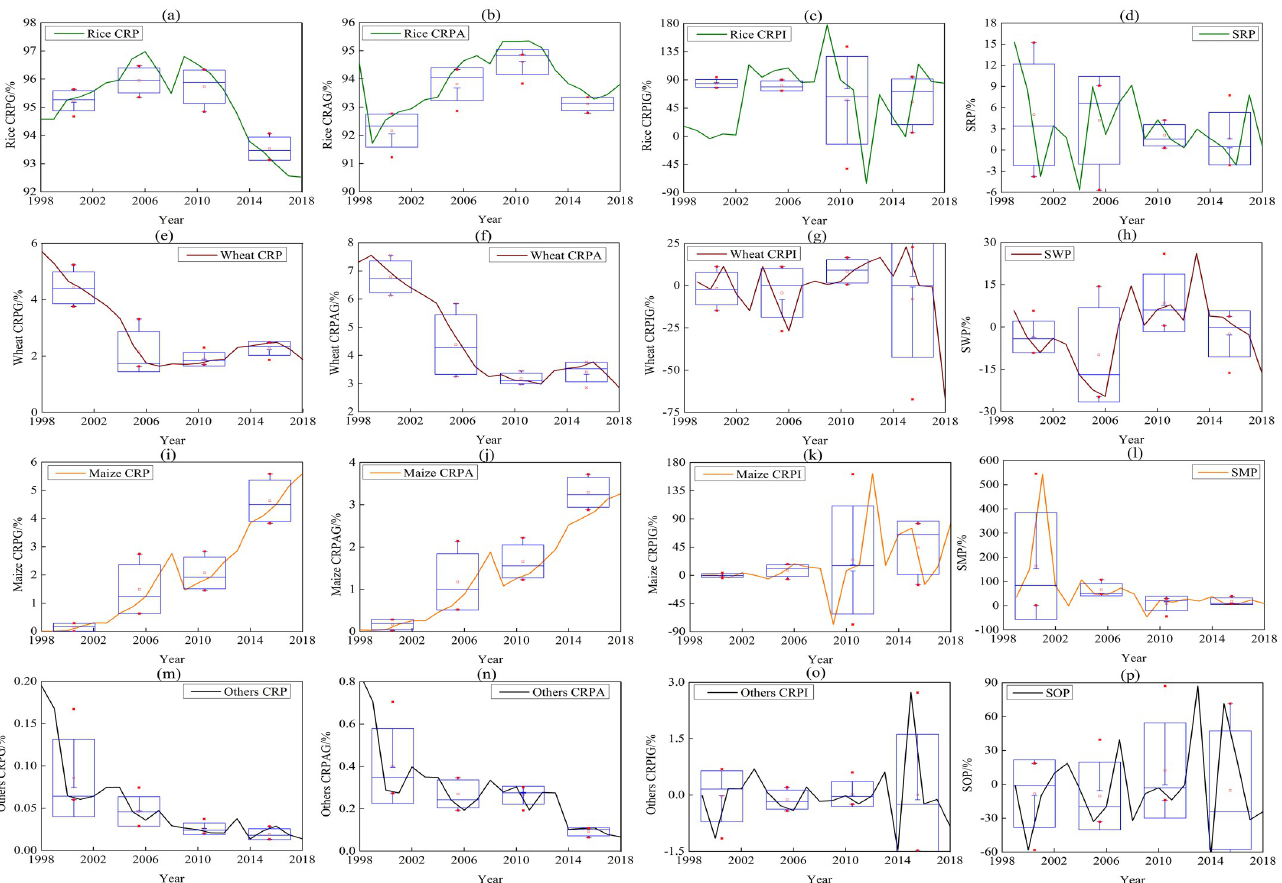
Fig 3. Main grain crops production change in Bangladesh from 1998 to 2018. This figure showed the variation trend of CRP, CRPA, CRPI, SRP, SWP, SMP and SOP in rice (a, b, c, d), wheat (e, f, g, h), maize (i, j, k, l) and others (m, n, o, p) at different periods. (CRP: contribution rate of production, CRPA: contribution rate of planting area, CRPI: contribution rate of production increase, SRP: stability of rice production, SWP: stability of wheat production, SMP: stability of maize production, SOP: stability of others